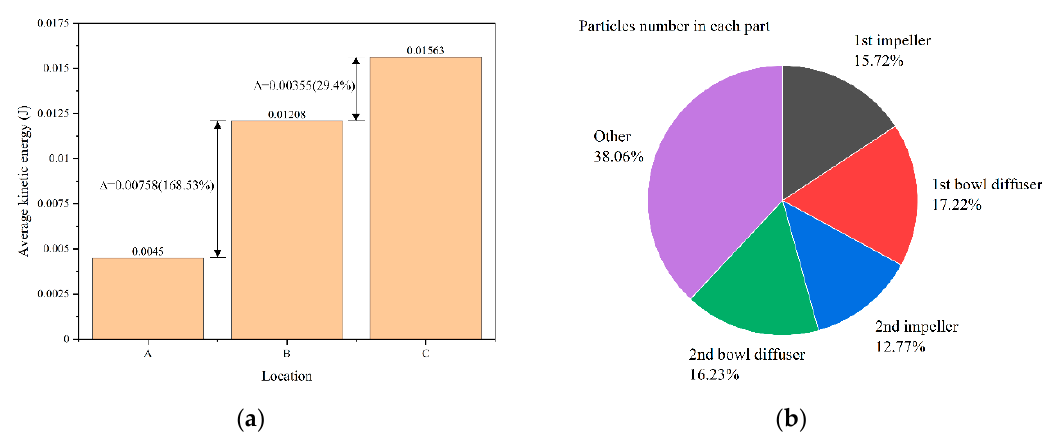
Figure 10. ( a ) Average kinetic energy of particles at the inlet of the first stage, the transition area between stages, and the outlet of the second stage; ( b ) the percentage of the particle number.